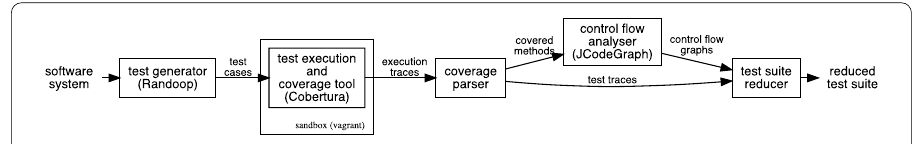
Fig. 2 General framework. The developed tool-chain consisting of test generation, code coverage assessment, control flow graph extraction, and reduced test suite